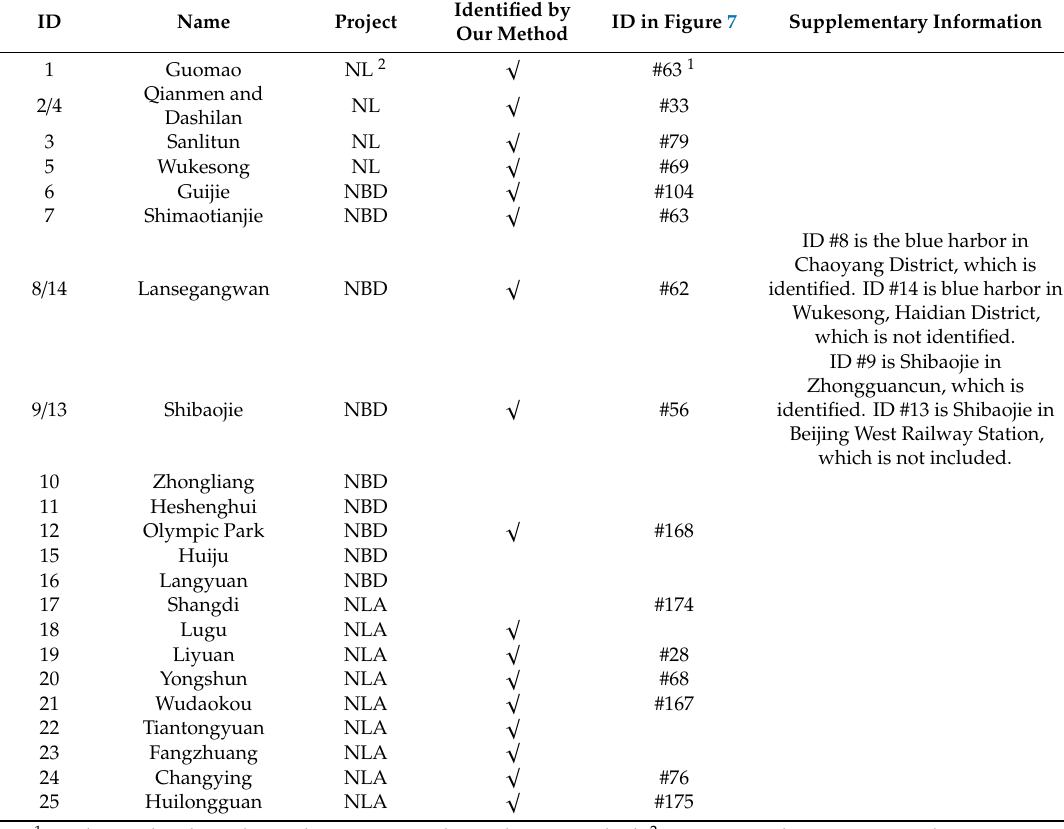
Table 4. Comparison table between the identified UNLSs and planned nighttime life